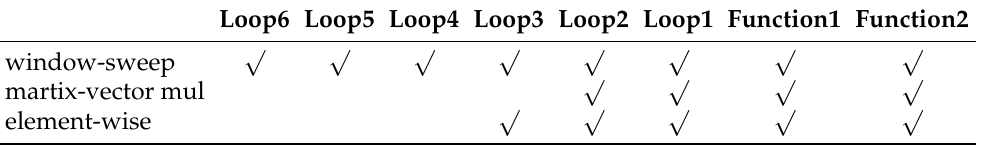
Figure 2. Pseudocode for ( a ) fused algorithm and ( b ) paralleled convolution. Table 1. The framework components for different kernel